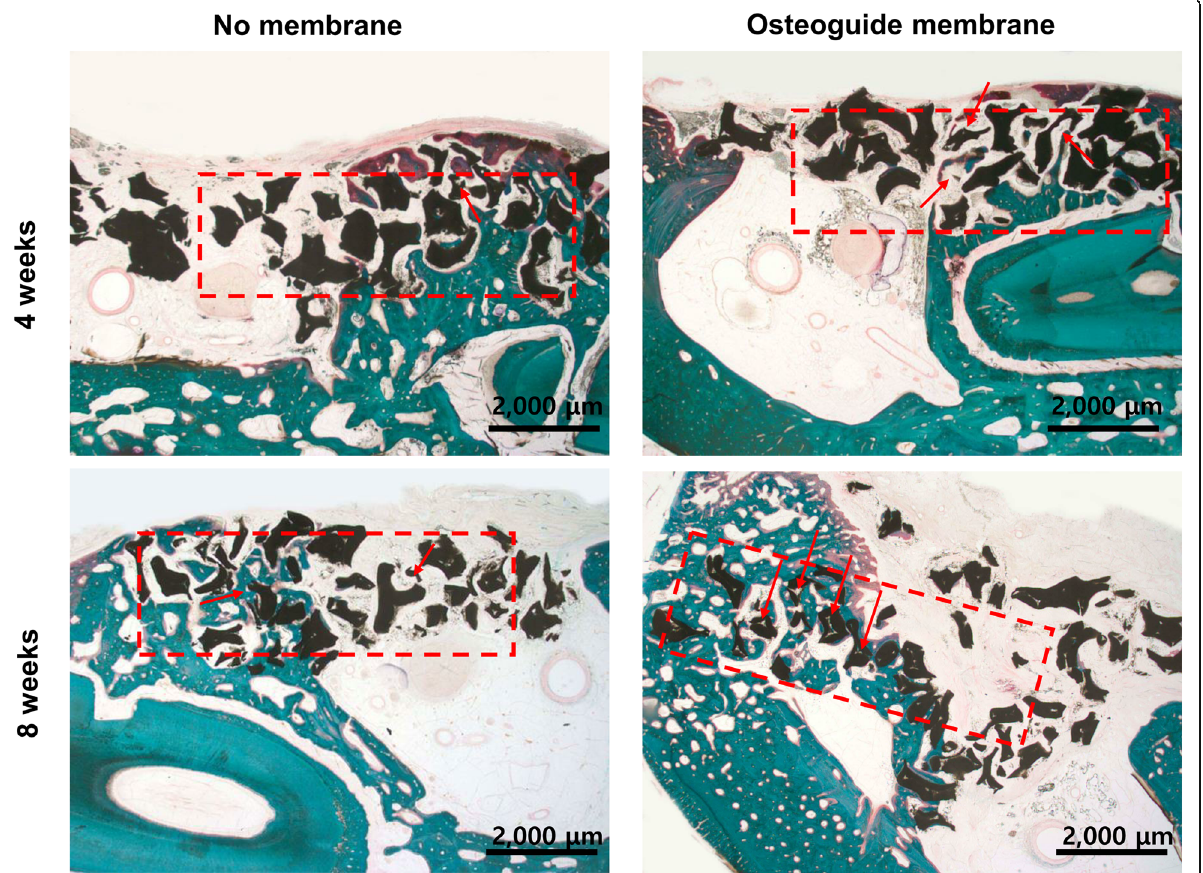
Fig. 2 Histologic findings on the experimental and control groups at 4 and 8 weeks postoperatively. Newly formed bone (green) and remaining graft (black) volumes were calculated based on the total area (12 mm 2 area, red square), respectively. The biodegradation in osteon was pointed as arrow. At 4 weeks, immature new bone was formed around graft material, large amount of woven bone with small portion of mature bone was formed around graft material. At 8 weeks, large amount of new bone was formed around graft material, and trabecular containing many osteoblasts were detected around graft material. The Osteoguide showed resorption progression and calcium particles are observed on the Osteoguide area without inflammation tissue. The covered shape of osteoguide was irregular pattern. There was shown to delayed new bone formation as fibrous tissue formed earlier than osteogenesis